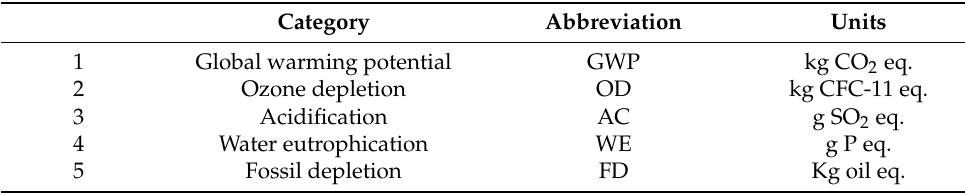
Table 3. Selected indicators categories for LCIA.